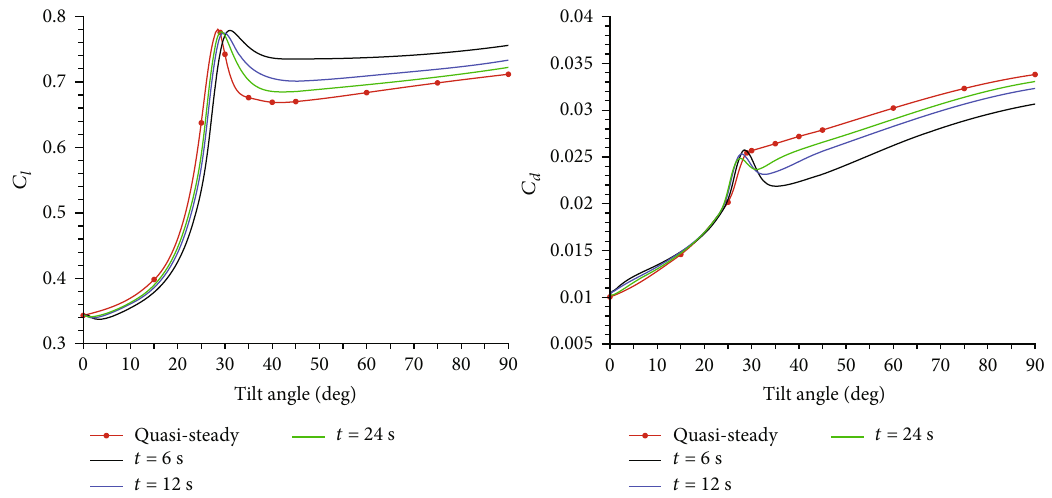
Figure 23: Unsteady aerodynamic coe ffi cients for di ff erent conversion period times.